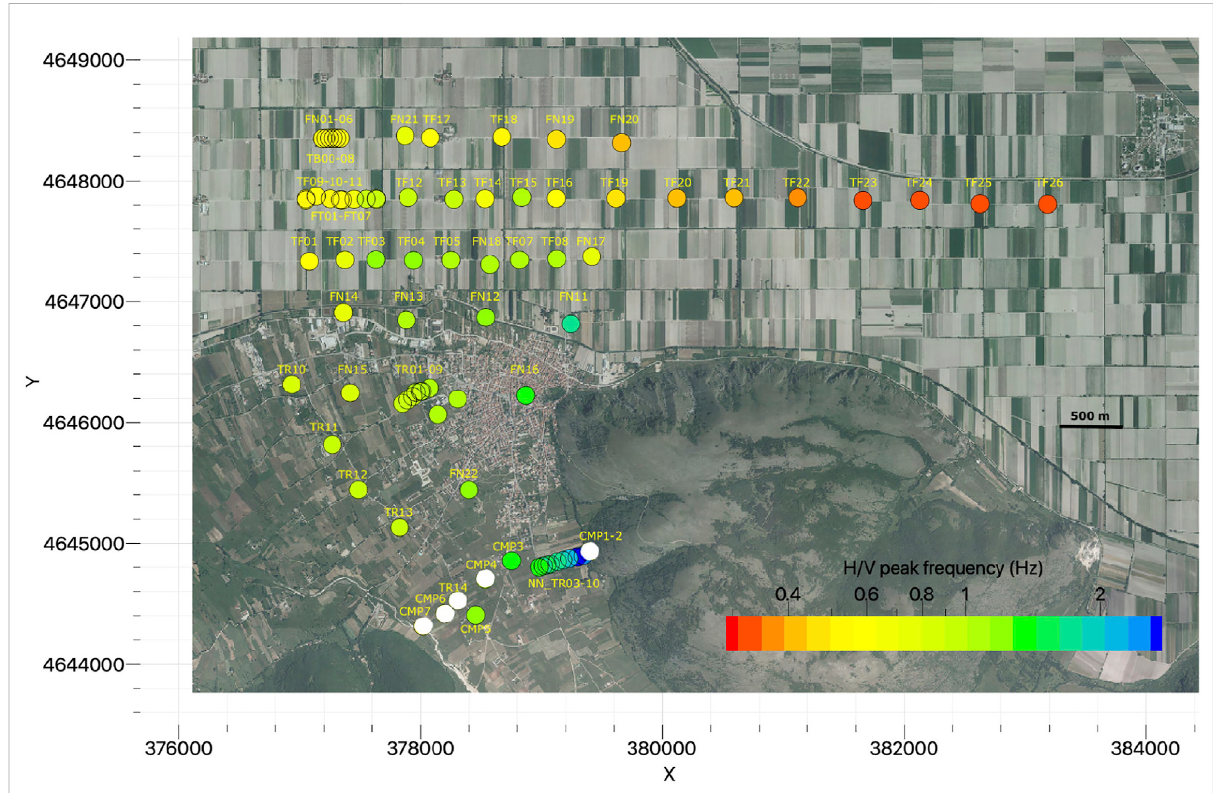
FIGURE 3 F0 map with the location of the HVNSR measurements (results in Supplementary Appendix S1). The color band represents the f0 value of each point of measure. White circles represent measures with no resonance peak or with bad quality